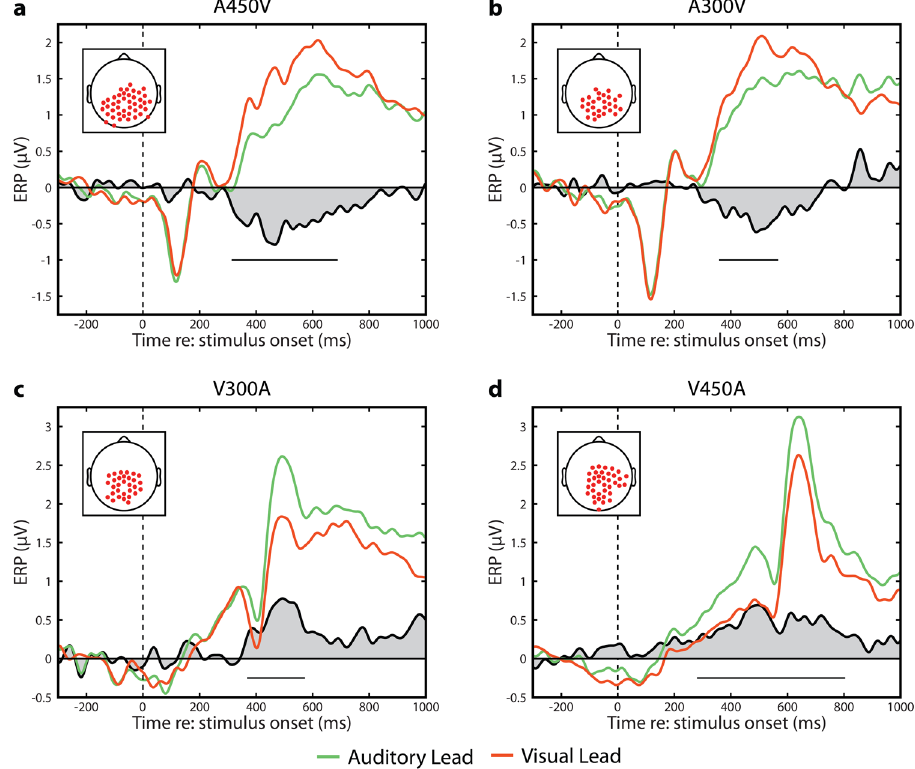
Figure 5. ERPs for large SOAs (A450V, A300V, V300A, and V450A) divided by the SOA of the previous trial. Insets depict the cluster of electrodes selected in each condition. ( a ) ERPs in the A450V condition binned depending on whether the previous trial was an auditory lead (green) or a visual lead (orange). Significant differences between A lead and V lead trials are present from 313–689 ms (p = 0.0003, randomization test), and are depicted by the black line. The grey shaded area highlights the difference between conditions. ( b ) ERPs in the A300V condition binned depending on whether the previous trial was an auditory lead (green) or a visual lead (orange). Significant differences are present from 358–567 ms (p = 0.0013, randomization test), and are depicted by the black line. The grey shaded area highlights the difference between conditions. ( c ) ERPs in the V300A condition binned depending on whether the previous trial was an auditory lead (green) or a visual lead (orange). Significant differences are present from 368–573 ms (p = 0.0032, randomization test), and are depicted by the black line. The grey shaded area highlights the difference between conditions. ( d ) ERPs in the V450 condition binned depending on whether the previous trial was an auditory lead (green) or a visual lead (orange). Significant differences are present from 280–804 ms (p = 0.0002, randomization test), and are depicted by the black line. The grey shaded area highlights the difference between conditions. A marginally significant effect is present from 183–261 ms (p = 0.0428, randomization